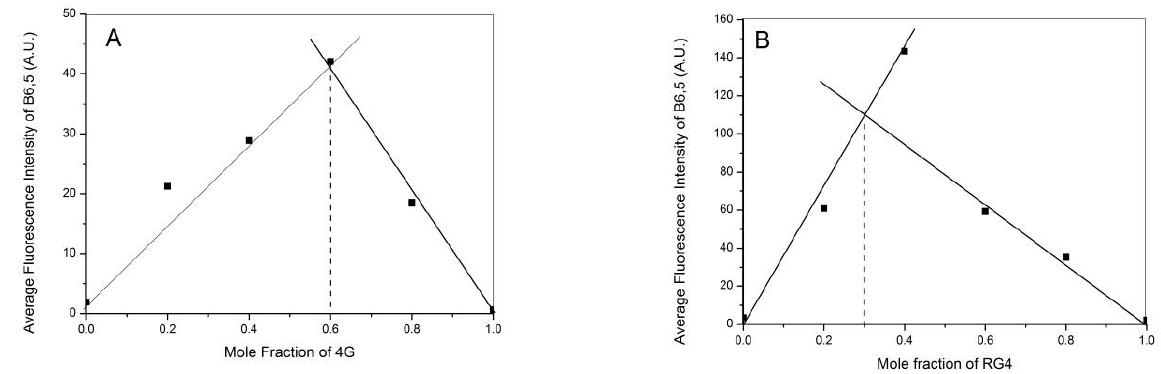
Figure 5. Job’s Plot for binding stoichiometry of B6,5 with quadruplexes ( A ) 4G and ( B )